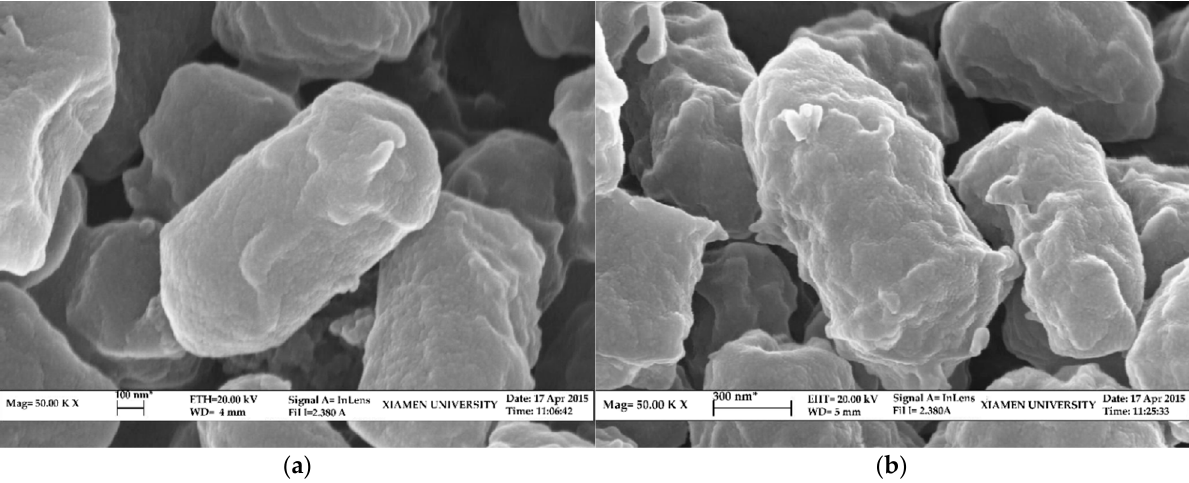
Figure 4. SEM images of strain TAW-CT127 in different media after 5 d culture. ( a ) SEM image of strain TAW-CT127 in the marine 2216 L–B medium. ( b ) SEM image of strain TAW-CT127 in the MMC medium.